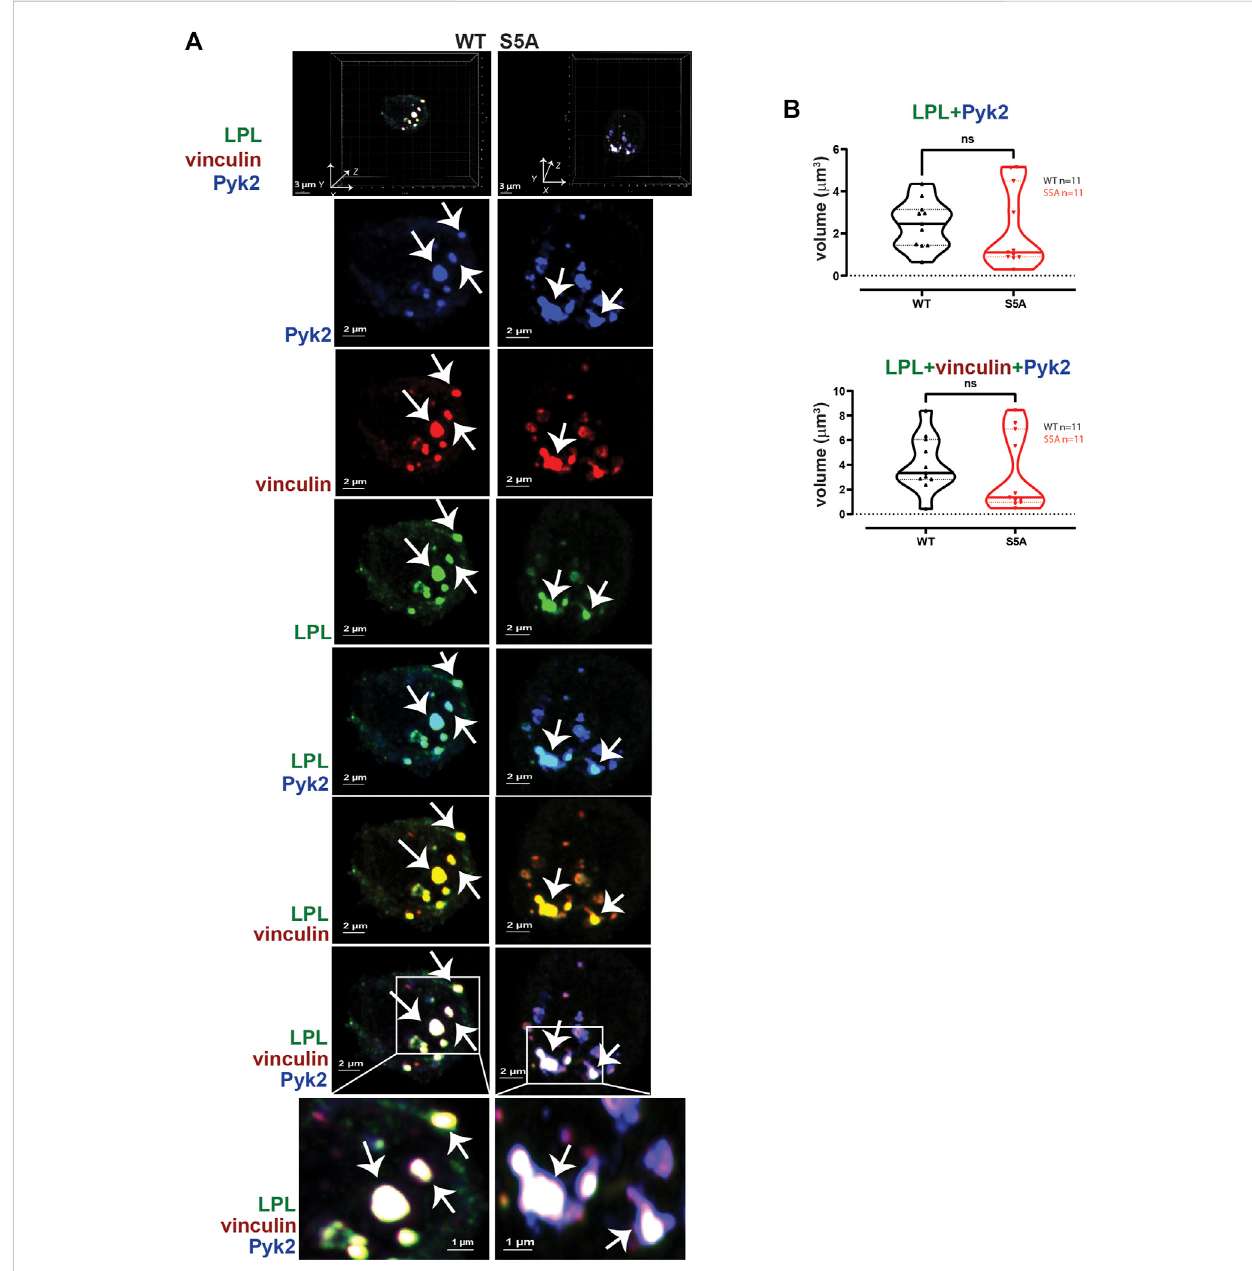
FIGURE 5 WT-LPLandS5A-LPLco-localizeequivalentlywithPyk2andvinculininAMsafterserumstimulation. (A) Co-localizationofLPL(green),vinculin(red) and Pyk2 (blue) in serum-stimulated AMs from matched WT and S5A mice. Top panel shows 3D reconstruction of Z-stack confocal micrographs. Individual proteinstaining,overlaysofPyk2+LPL(aqua),LPL+vinculin(yellow),andofLPL+vinculin+Pyk2(white)are2DXYprojections.Representative